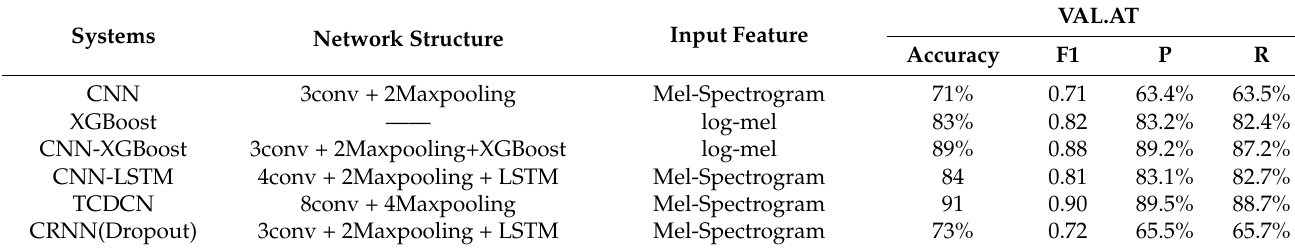
Table 4. Performance of the proposed systems on the validation (Val.).